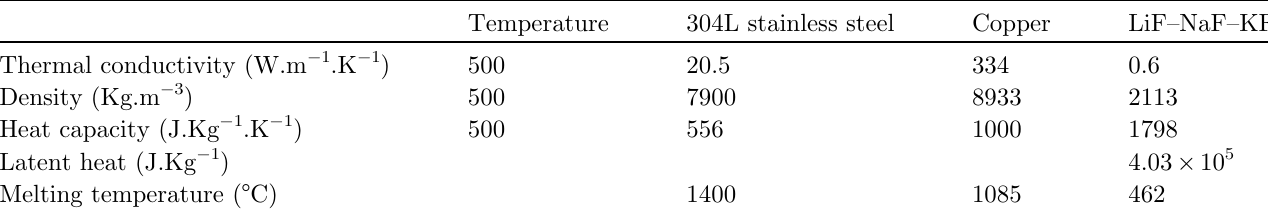
Table 1. Data used for the SWATH cold plug simulations.